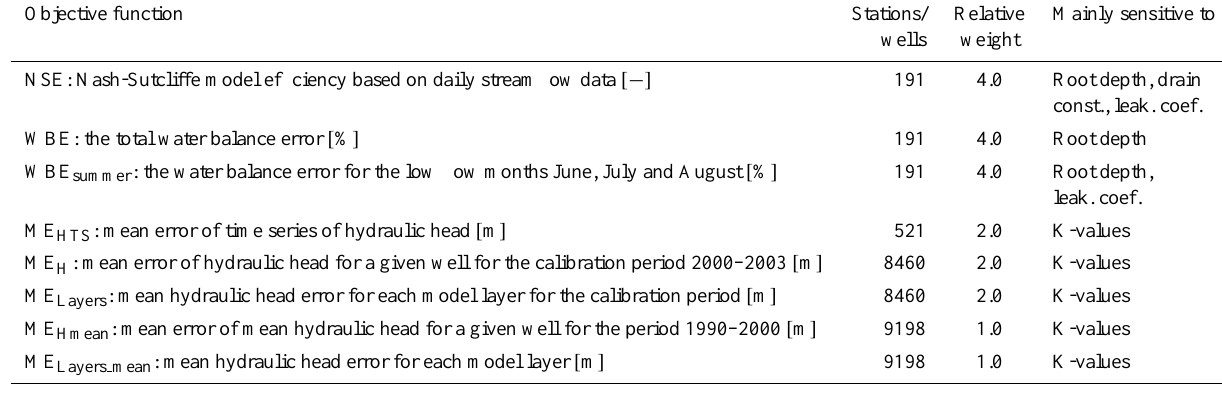
Table 3. The eight objective functions are defined as follows: Objective function Stations/ Relative Mainly sensitive to